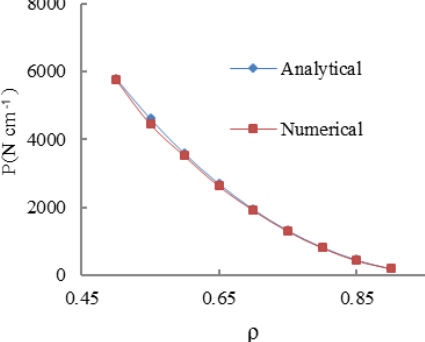
Figure 9. Analytical and numerical results for failure load P vs. radius ratio assuming tensile strength of 150MPa.